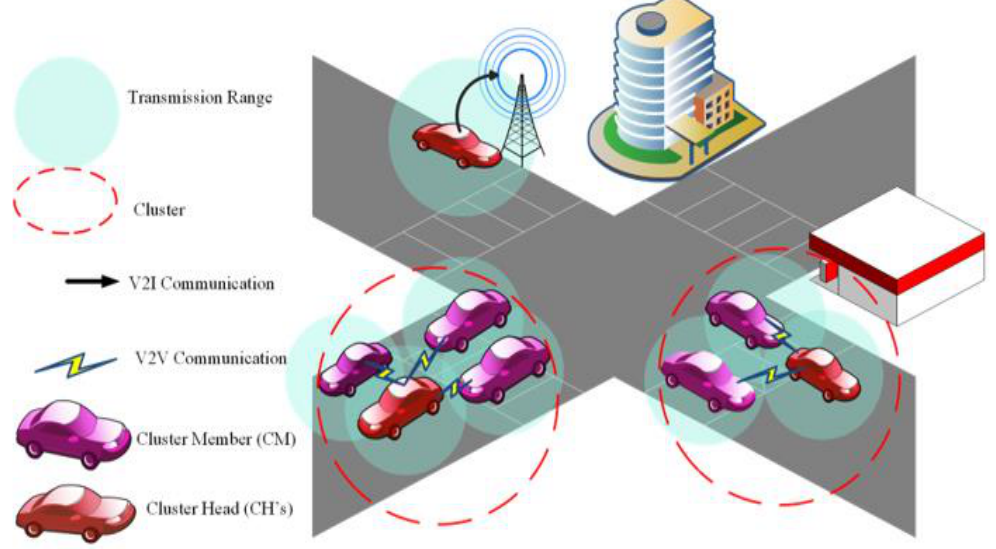
Figure 1. Node Clustering in vehicular ad-hoc networks (VANETs).